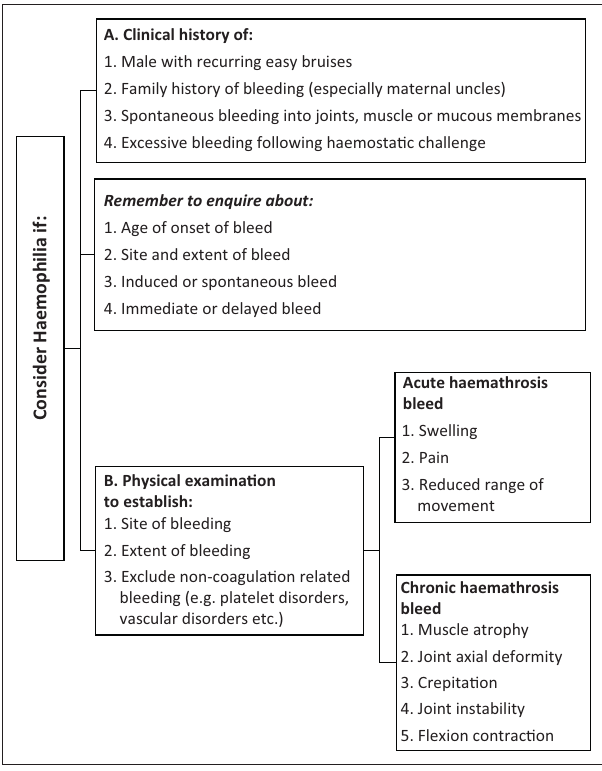
FIGURE 3: Algorithm to guide the clinical approach to a patient with suspected